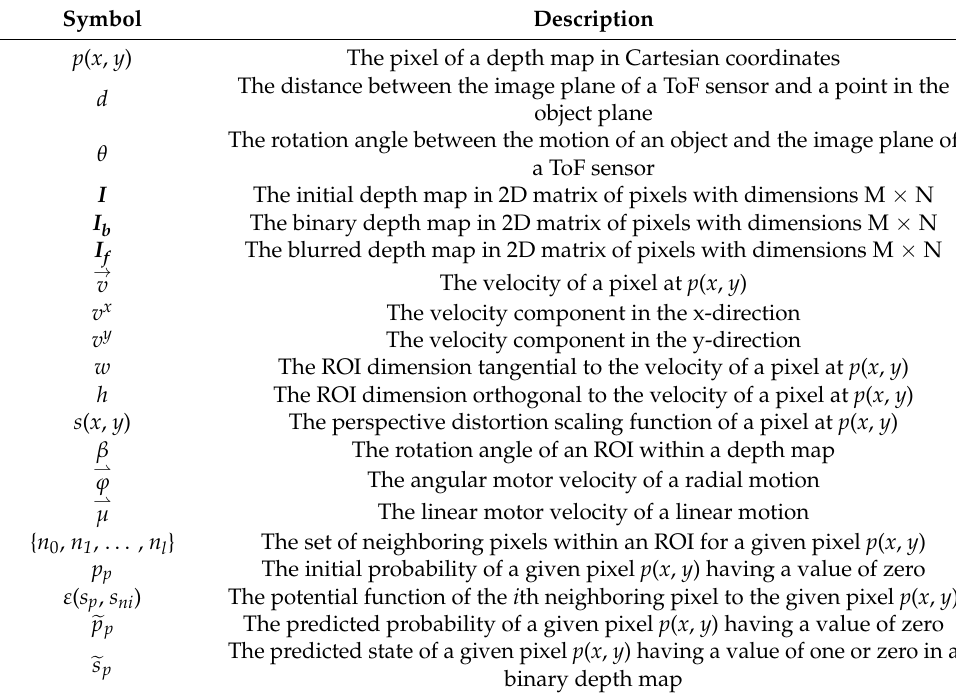
Table 1. Frequently used notations in this